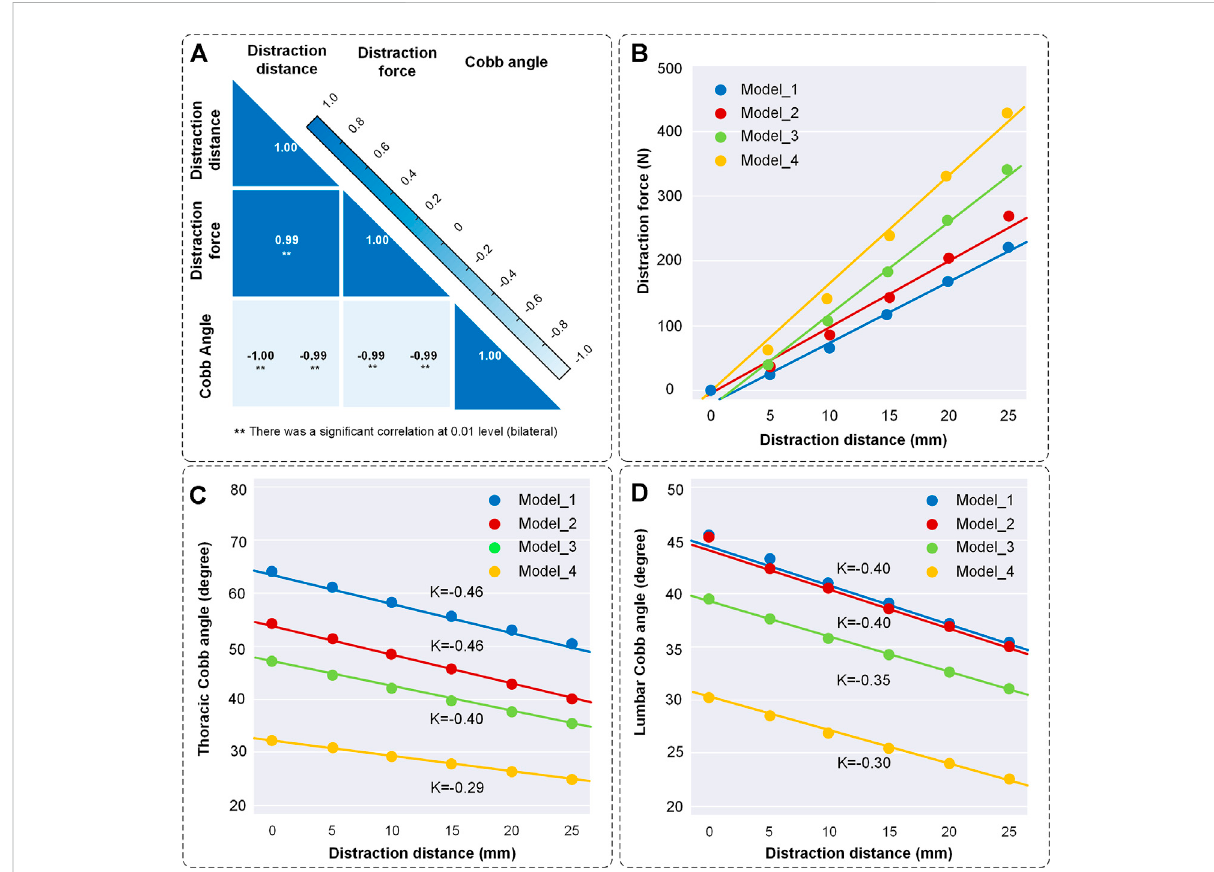
FIGURE 5 Changes of distraction force and the Cobb angle of thoracic and lumbar curves. (A) Correlation coef fi cient heatmap. The liner relations between distraction distance, distraction force and Cobb angle were normally distributed and signi fi cantly correlated at 0.01 level according to the Shapiro-Wilk test and Pearson correlation. (B) Scatter diagram of distraction distance and distraction force. K represents the slope of the curves. (C) Scatter diagram of distraction distance and the Cobb angle of thoracic scoliosis. (D) Scatter diagram ofdistraction distance and the Cobb angle of lumbar scoliosis. The straight was fi tted by scatter